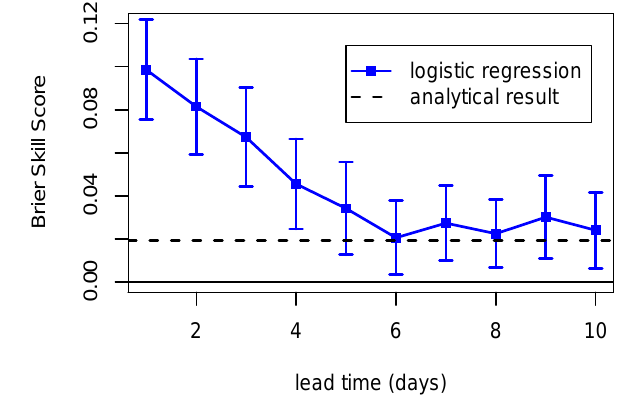
Figure 3. Brier Skill Score over lead time of estimated outlier prob- ability compared to base rate forecast. Error bars indicate 95% confidence intervals. For reference, the analytical result obtained in Sect. 3 using K = 50 is